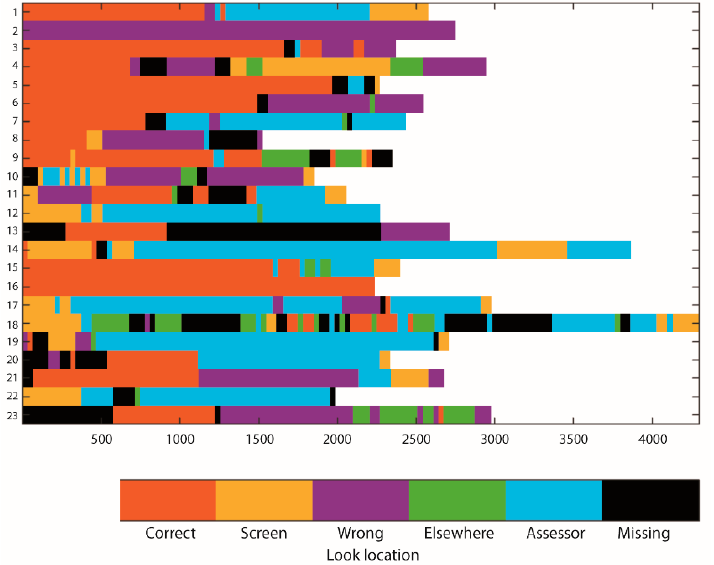
Figure 3. Raw looking behavior data (after interpolation of missing times < 150 ms) for the switch trial. Children who passed the first two A trials only are Cases 1–18; children who needed more than two A the